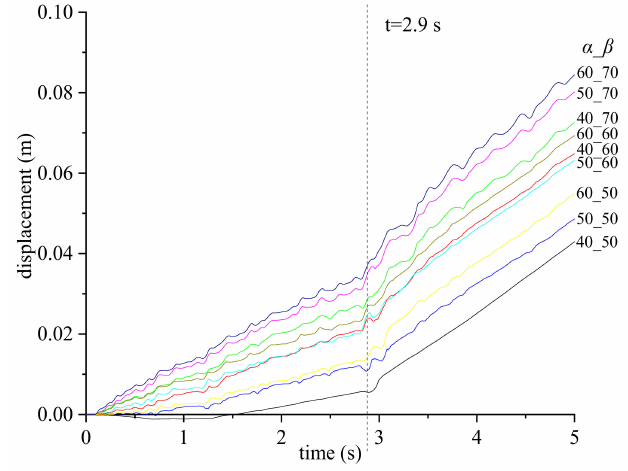
Figure 14. Displacement history of point D5 in the Y -direction for different slopes subjected to the action of a natural seismic wave. The slopes are labeled α _ β according to their α and β angles.